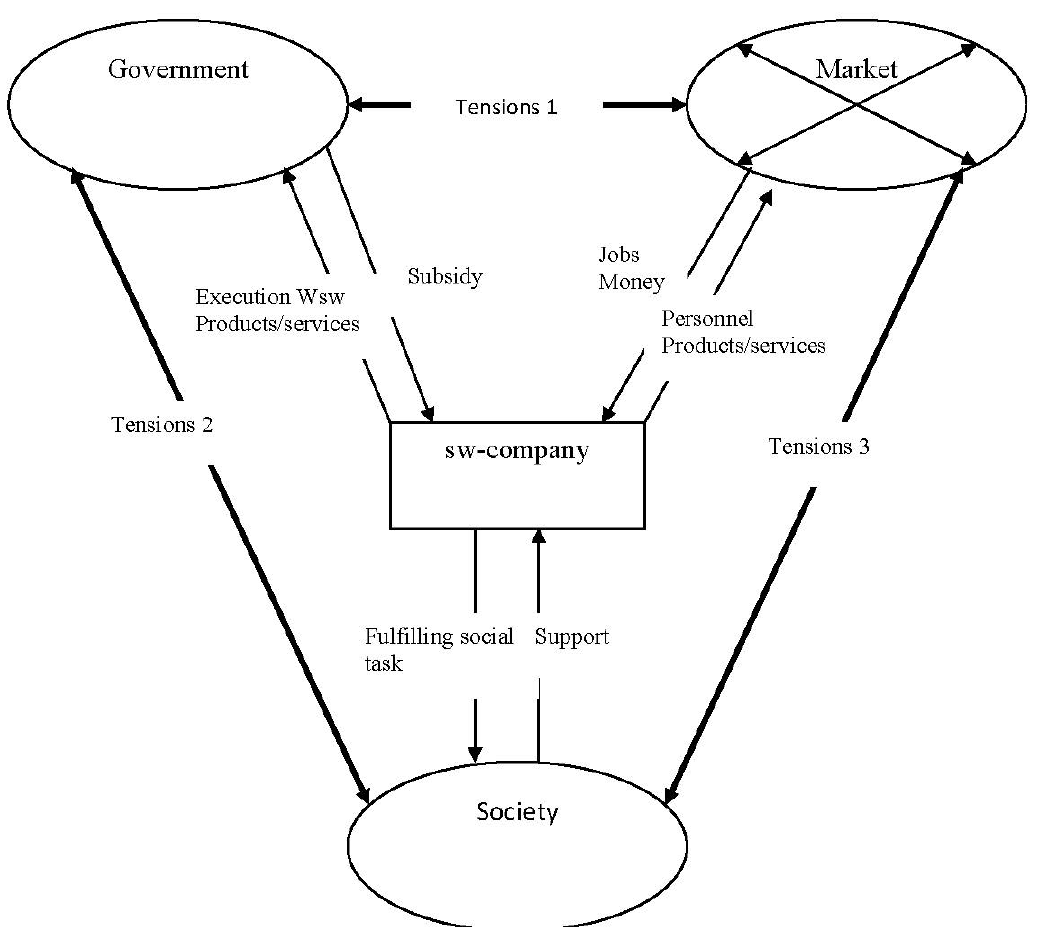
Figure 1. Marketing of sw-companies: dealing with fragmentation and